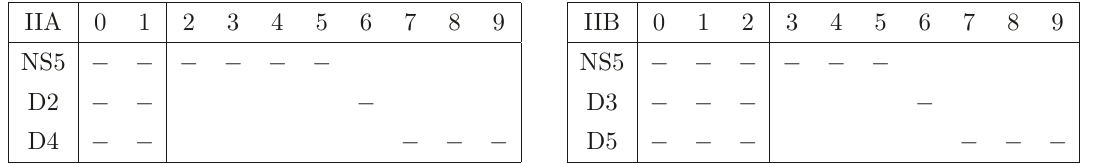
Table 4 . On the left is a type-IIA brane configuration, and on the right is the type-IIB brane configuration in [16] that corresponds to it by T-duality along the x 2 -direction (see also figure 4).